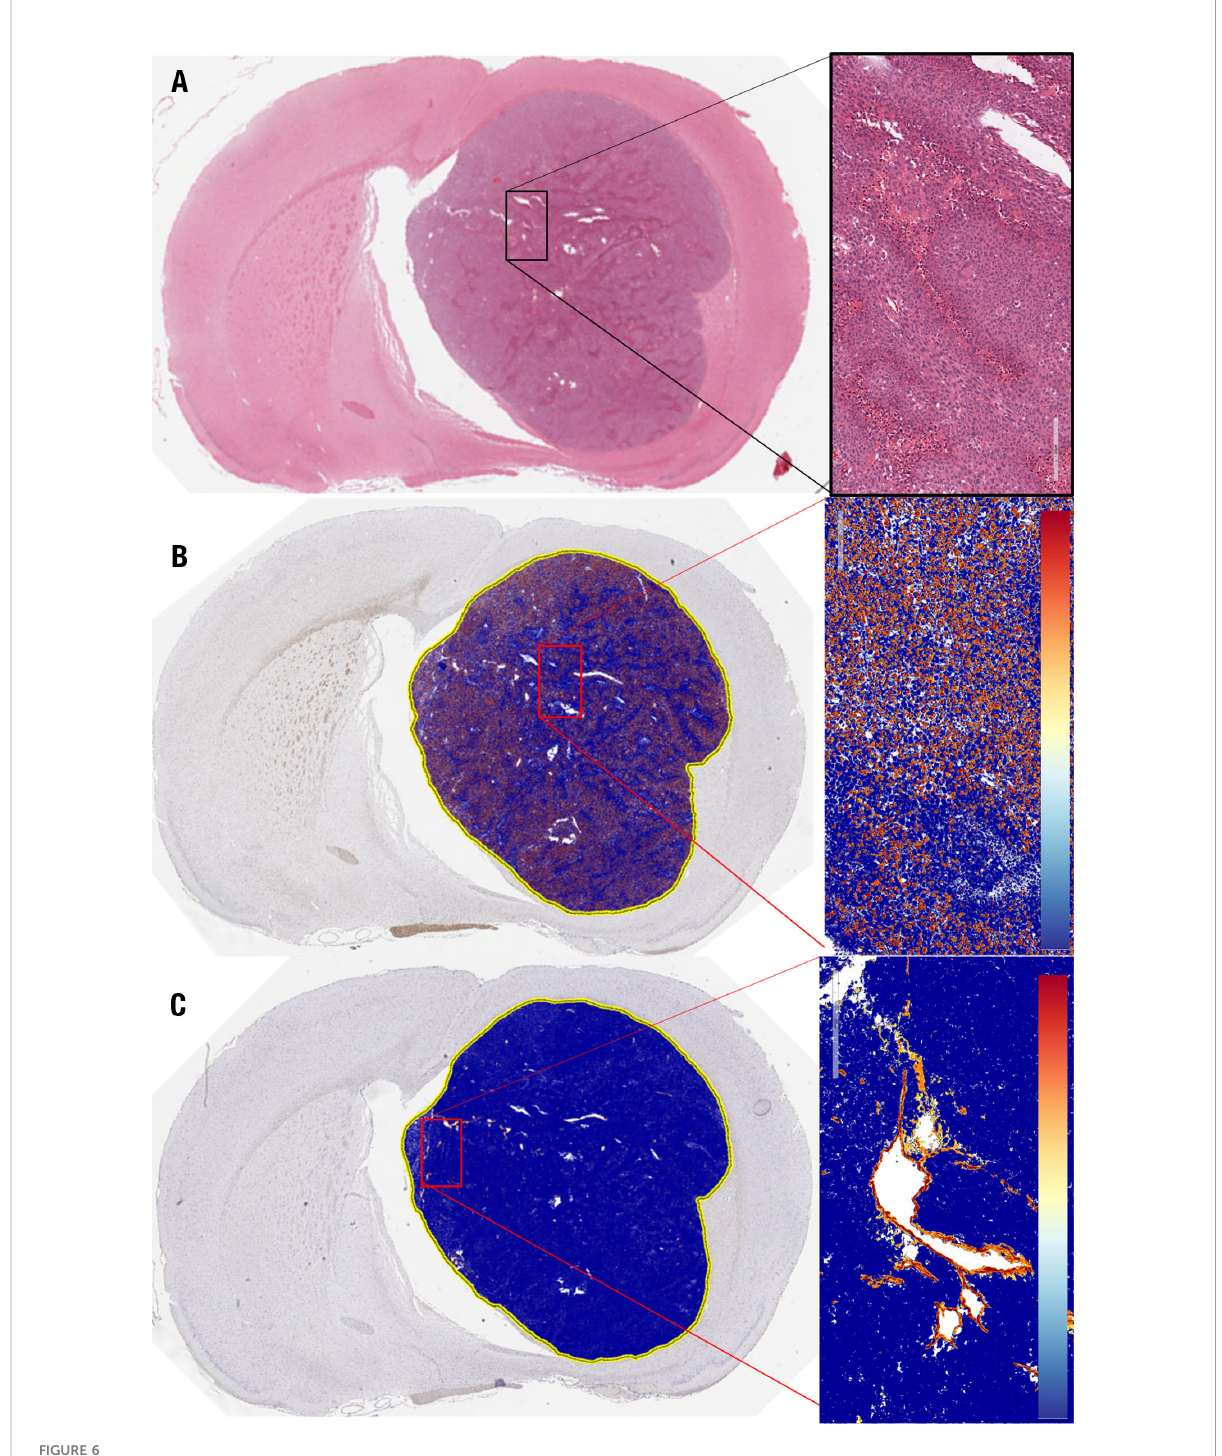
FIGURE 6 Histological analysis of GBM10 proliferation index and microvascular proliferation in a representative Rag2 -null rat. (A) Coronal cross-section of the tumor, with a higher-resolution image of a region within the tumor (insert) demonstrating the high degree of cellularity and vascularity. (B) Ki67 staining of the same tumor as in (A) , with a higher-resolution image of a region within the tumor (insert). (C) von Willebrand factor VIII staining of the same tumor as in (A, B) , with a higher-resolution image of a region within the tumor